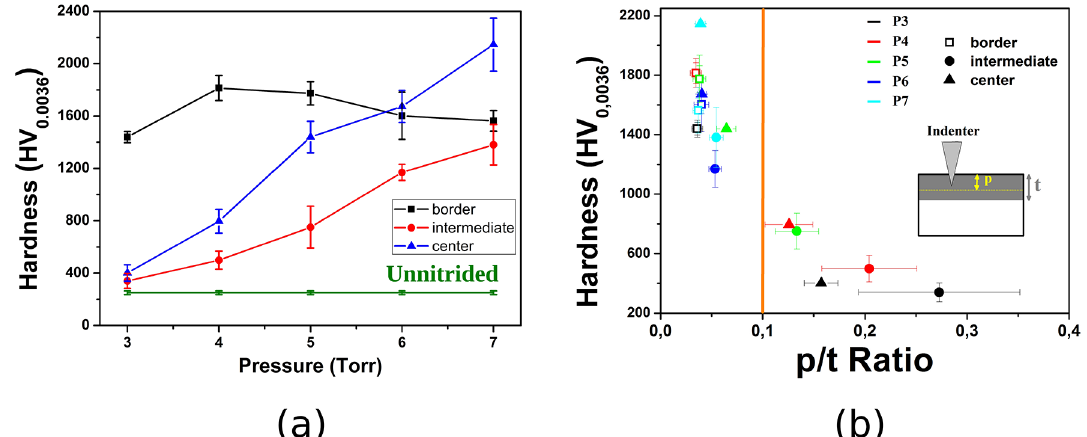
Figure 3. (a) Hardness values on border, intermediate and central regions as a function of the nitriding pressure; (b) Hardness values as a function of the ratio between penetration depth (p) and nitrided layer thickness for the different regions of the nitrided samples.